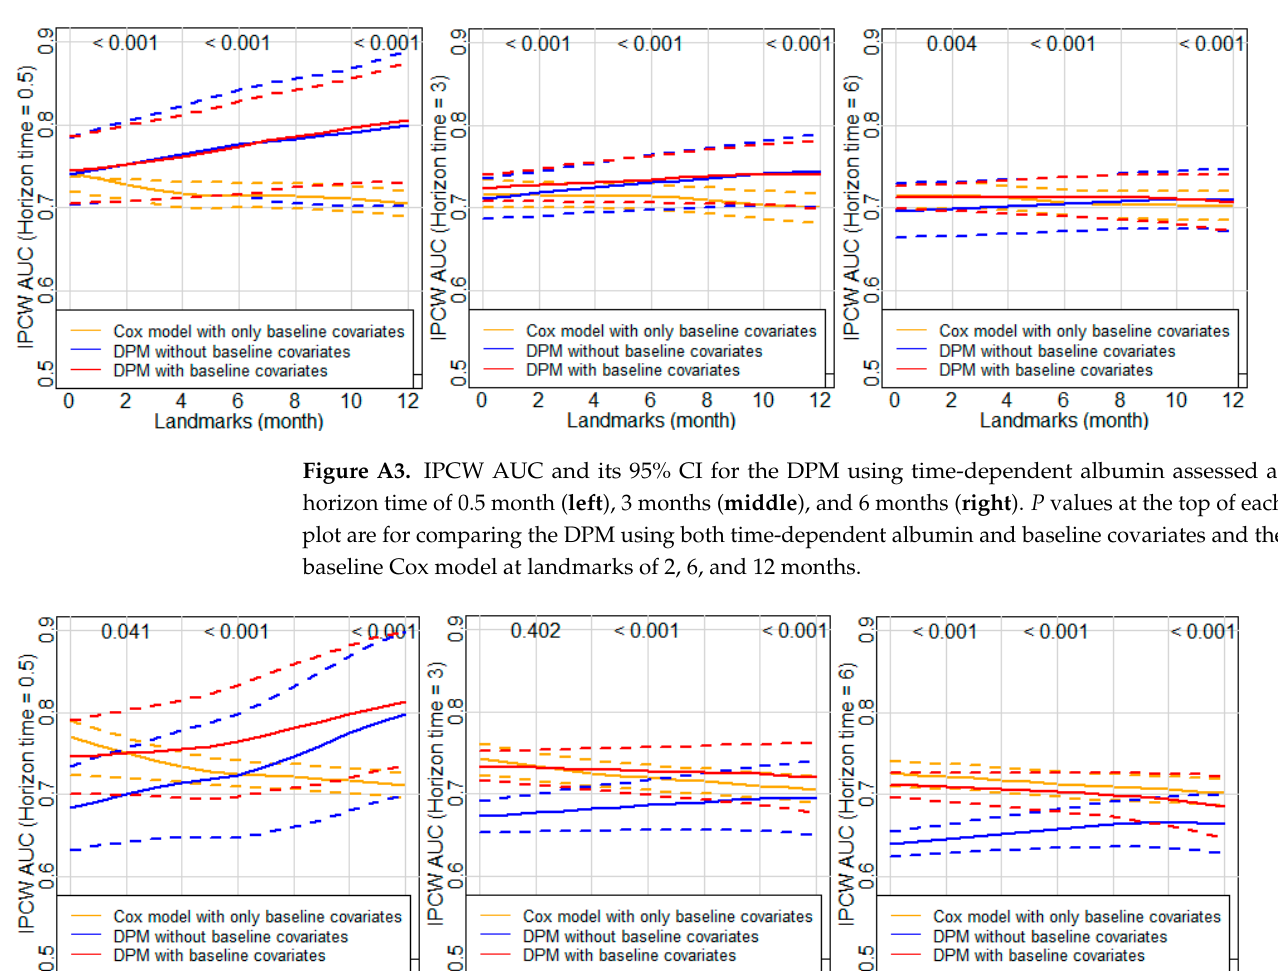
Figure A1. Distribution of spline basis functions based on landmarks. Figure A2. Flowchart of the data cleaning approach.